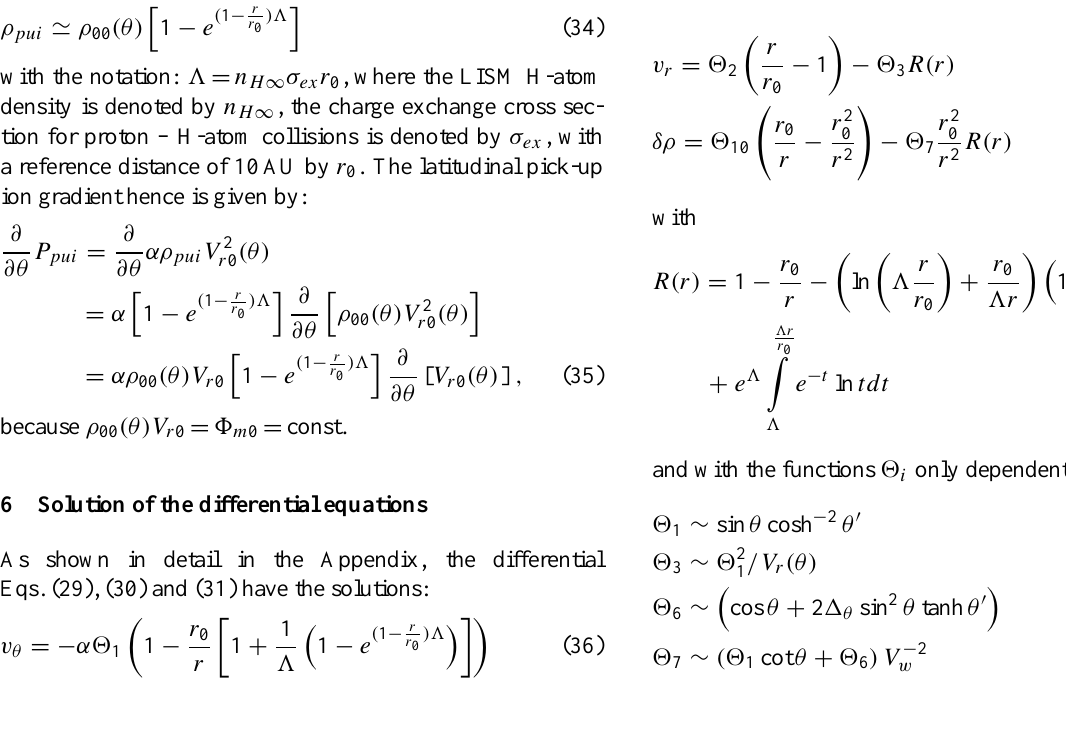
Fig. 4. The ratio of density perturbation and the undisturbed den- sity: δρ/ρ 0 . The labels are analogous to that of Fig. 2, except for the colour-code, which now gives the ratio of the density perturbation and the undisturbed